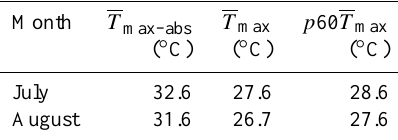
Table 2. Values of the average of the absolute maximum temper- ature, the average of the maximum monthly temperature and the 60th percentile of the average of the maximum monthly tempera- ture recorded during the period 1961–1990 at the Barcelona–Fabra weather station (Barcelona).